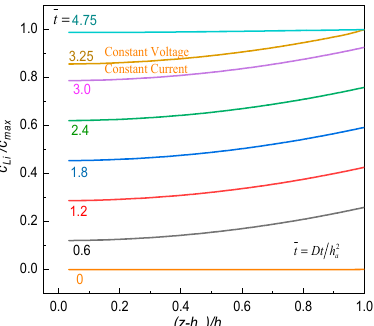
Figure 7. Lithium-ion profiles in active layer at different lithiation times.